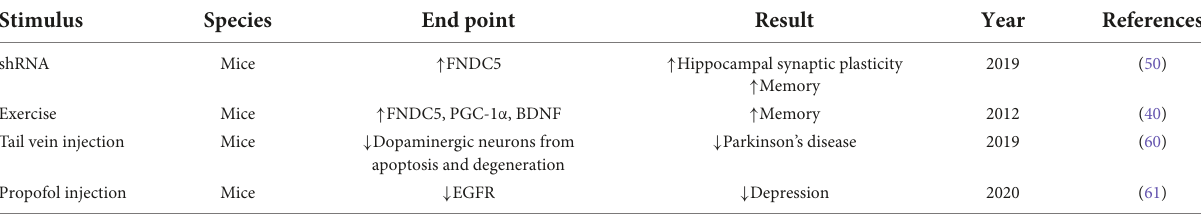
TABLE 1 Preclinical and clinical studies on irisin and Alzheimer’s disease and Alzheimer’s disease-related dementia. Stimulus Species End point Result Year